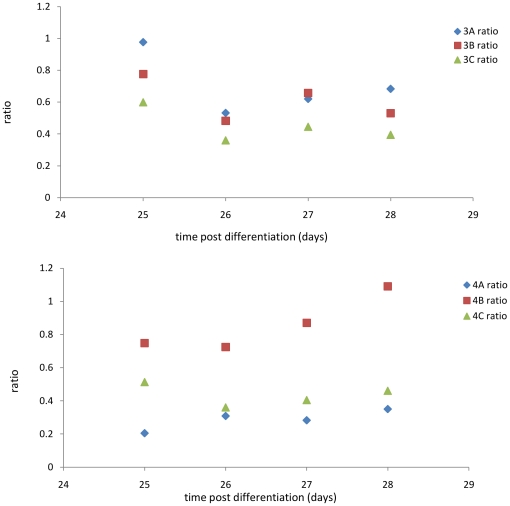
Differential mechanosensation response for Cohort 3 (upper graph) and Cohort 4 (lower graph).Each group (3A, 3B, 3C, 4A, 4B, 4C) was divided in half 20 days after the onset of differentiation, monolayers in each half either exposed to orbital shaking or not. The ratio of transepithelial sodium current of paired shaken and unshaken monolayers was used to quantify the long-time flow-sensing mechanosensation response. In all cases except 4B (discussed in the text), monolayers responded to the presence of flow by decreasing Isc relative to monolayers in quiescent conditions. In particular, the differential response of Cohort 4 was attenuated over time, indicating that flow conditions post-differentiation have less of an effect than flow conditions present during differentiation.